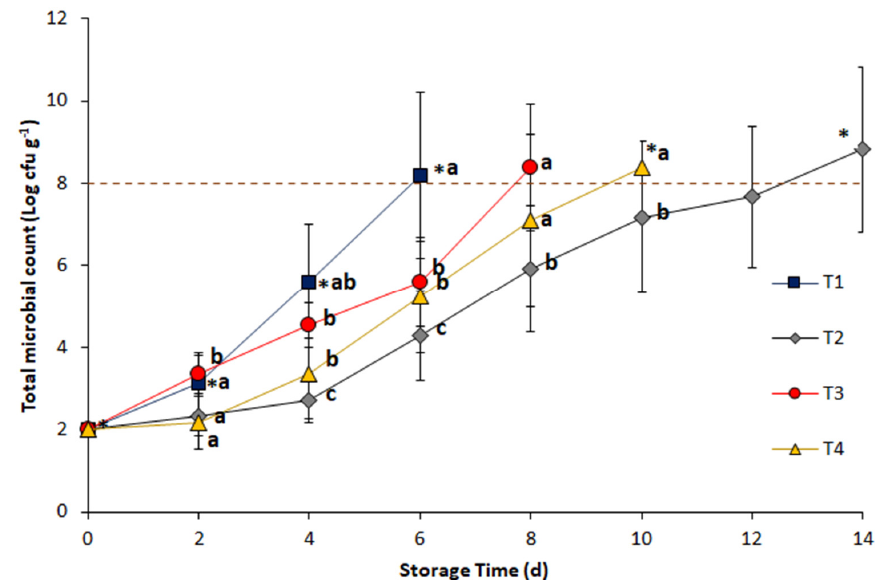
Figure 1. In vitro growth of Pseudomonas spp. under different antimicrobial treatments at 4 °C. T1: control; T2: 1%nisin + 0.05%oreganoessentialoil; T3: 0.05%oreganoessentialoil; T4: 1%nisin. Di ff erent letters indicate significant di ff erences between treatments for the same sampling day. The asterisk indicates significant di ff erences between consecutive measurement days for the same treatment according to Tukey’s HSD test ( p ≤ 0.05). Standard deviation included ( n = 3).